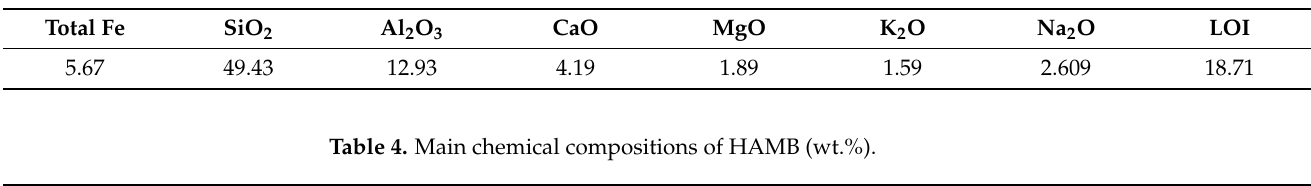
Table 3. Main chemical compositions of bentonite (wt.%).